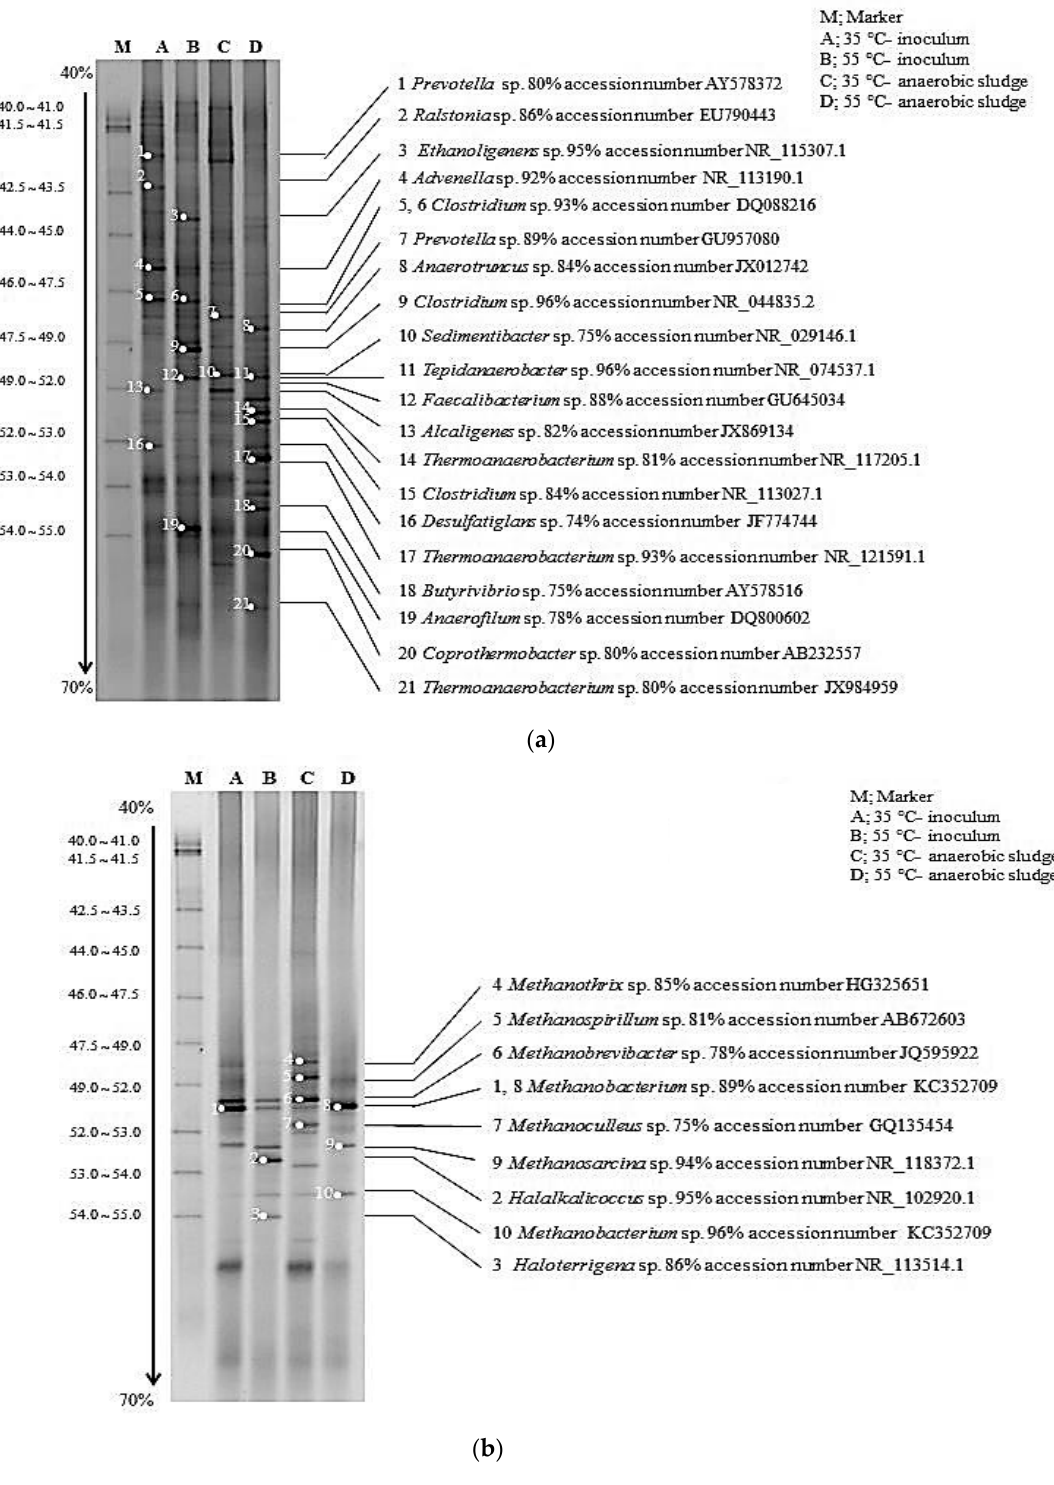
Figure 3. DGGE profiles of 16S rDNA gene fragment for bacteria ( a ) and archaea ( b ) from SS - AcoD of EFB : DC at 1 : 1 mixing ratio of 35 °C - inoculum ( A ) , 55 °C - inoculum ( B ) , 35 °C - anaerobic sludge ( C ) , and 55 °C - anaerobic sludge ( D ) .